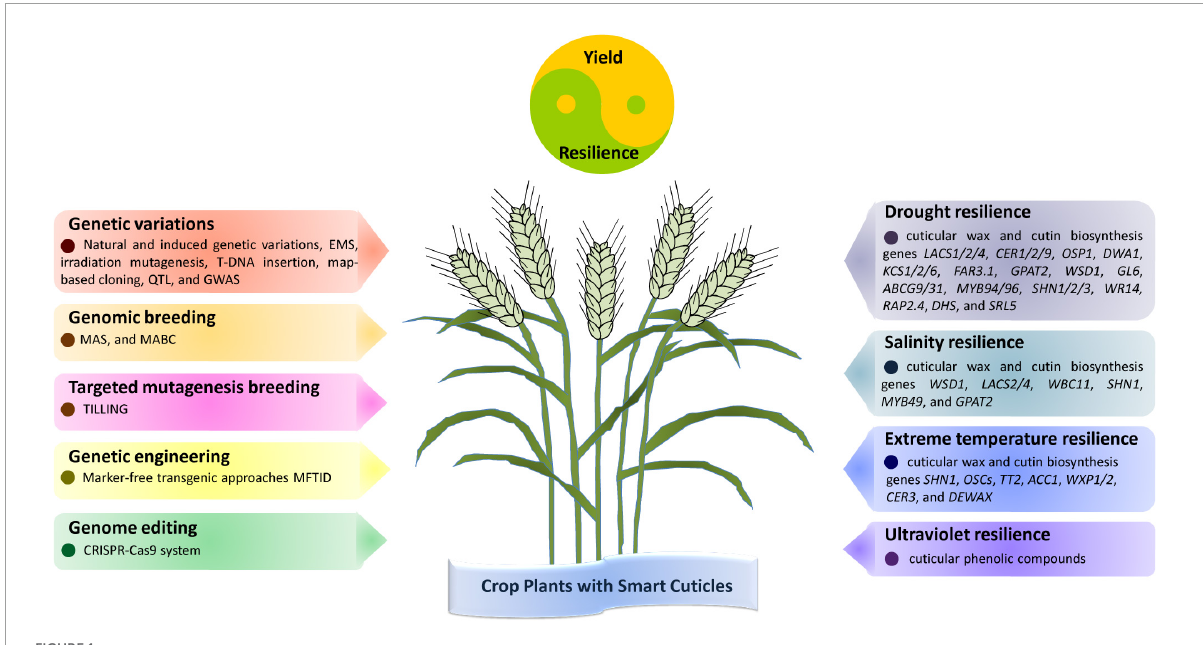
FIGURE1 Strategies and targets in harnessing cuticle biosynthesis for crop resilience to drought, salinity, temperature, and ultraviolet (UV) stress. Cuticle-related genetic variations could be either identified from natural populations or artificially induced, which would facilitate crop breeding for cuticle-associated traits through genomic breeding. In addition, crop plants with improved resilience to drought, salinity, temperature, and UV stress could be generated by targeted mutagenesis, genetic engineering, and genome editing of cuticle biosynthesis genes. These crop plants with smart cuticles would display improved performance in yield and resilience under drought, salinity, temperature, and UV